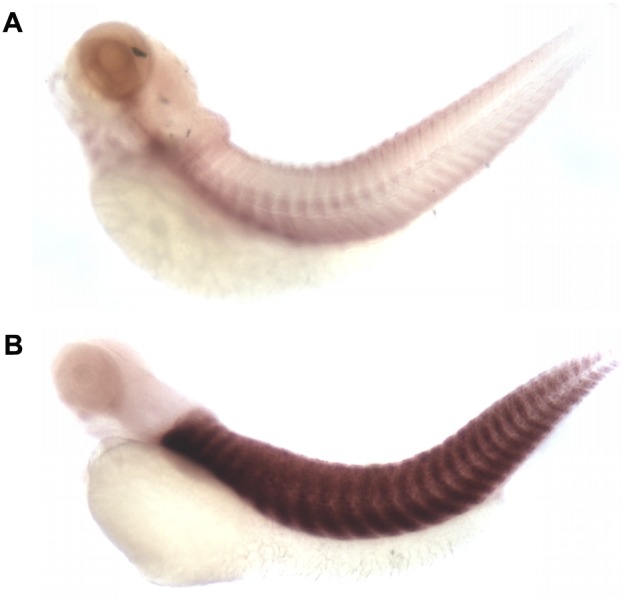
Expression of m3ck in transgenic fish by in situ hybridization.Whole-mount in situ hybridization was used to detect m3ck expression in wild-type (A) and Tg (smyd1:m3ck) fish (B) at 72 hpf. The signal was evaluated by microscopy for color detection of immunoreactive signals. Scale bars = µm.